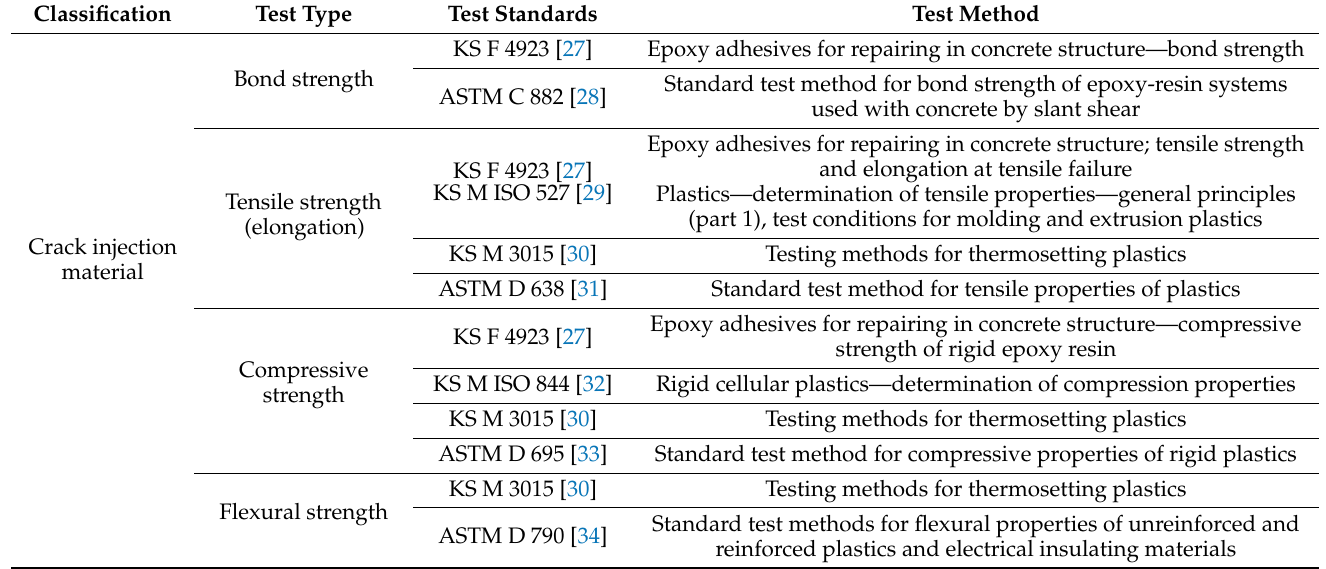
Table 6. Test standards and methods for crack repair material [27–34].